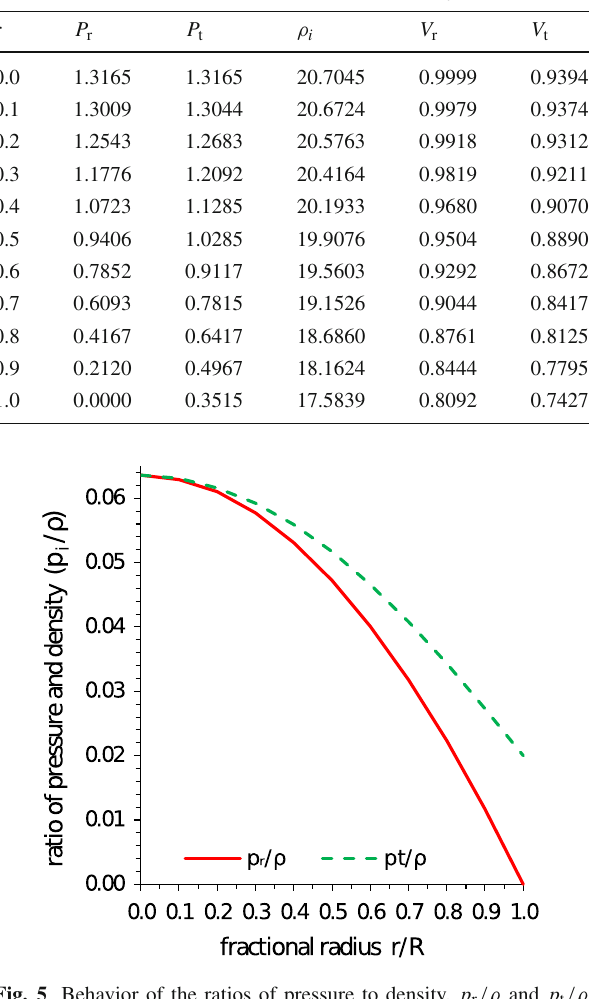
Table 1 Values of different physical parameters P r = 8 π p r / C , P